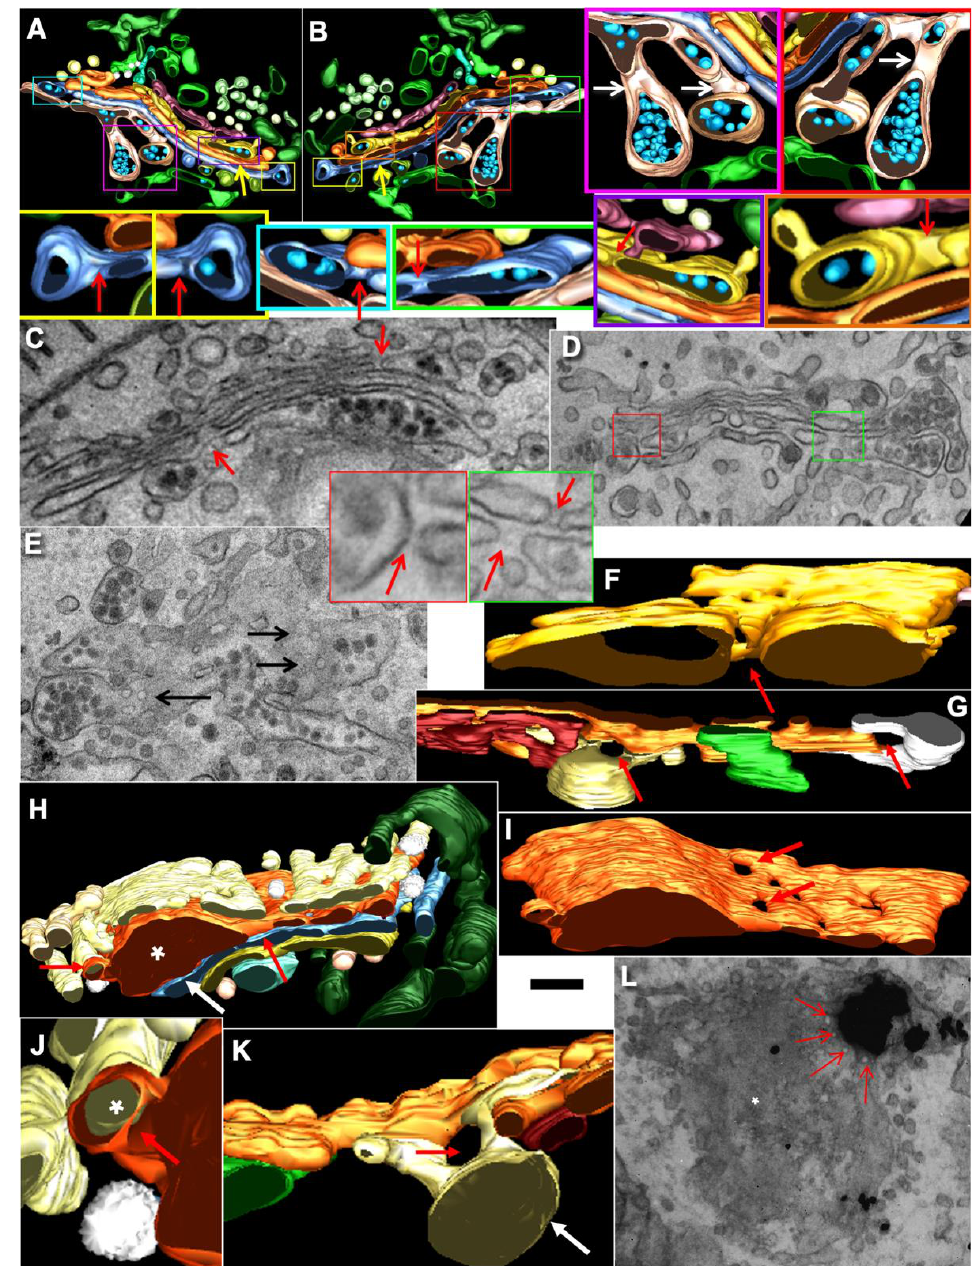
Figure 11. At steady-state ( A – E ) and during the mini-wave protocol ( F – L ), cisternal distensions filled with VLDLs ( A – E ) or procollagen-I ( F – L ) were separated from the rest of the Golgi cisternae by rows of pores. ( A – B , F – K ) EM tomography. ( C – E , L ) Representative transmission EM images. ( A , B ) Three-dimensional models of the Golgi complex of hepatocytes shown from opposite views (shown in Figure 3D). Green, ER. Several boxes with different colours of their borders were enlarged and demonstrated pores separating distensions filled with VLDLs. Red arrows, pores; yellow arrows, medial cisternae; blue spheres, VLDLs. ( C , D ) Pores (red arrows) between VLDL distensions and the rest of Golgi cisternae. Below: Enlargements of the areas inside the red and green-bordered boxes in ( D ). ( E ) Tangential section of Golgi cisternae with pores (black arrows). ( F – K ) Three-dimensional models that show pores (red arrows) between cisternae and PCI distensions. White asterisks in ( H ) and ( J ) indicate the lumen of cisternal distensions. ( J ) Red arrow, continuity between PC distension and another cisterna. ( L ) Tangential section of the Golgi stack. White asterisk indicates Gollgi cisterna. Scale bars: 210 nm ( A , B ); 120 ( C , F – I , K ); 170 nm ( D , E ); 240 nm ( L ).